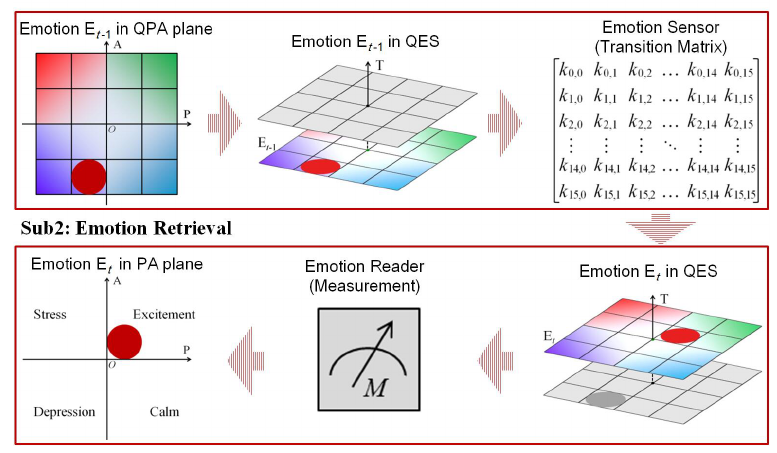
Figure 6. Quantum emotion transition and